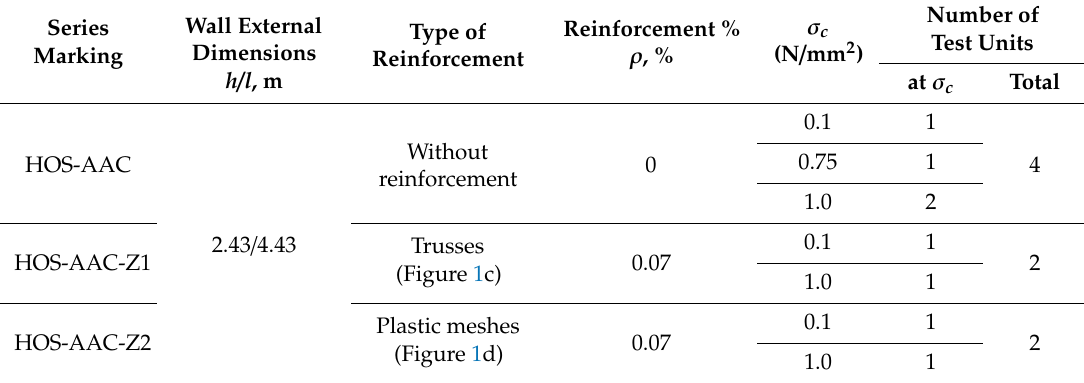
Figure 4. Geometry of models made of AAC masonry units, dimensions are in centimeters. Table 3. Research programme for walls made of AAC masonry units.